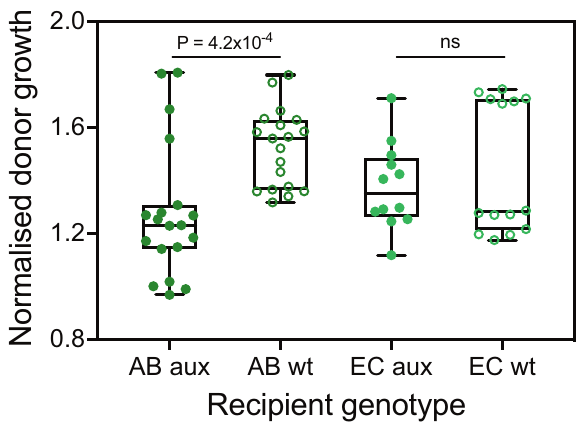
Fig. 3 Both auxotrophic and prototrophic genotypes bene fi t donors in coculture. Cocultures of donor strains with either auxotrophic (aux, fi lled circles) or prototrophic (wt, empty circles) genotypes of Acinetobacter baylyi (AB, dark green) and Escherichia coli (EC, light green) reveal signi fi cant differences in the growth of donors for A. baylyi , but not E. coli (Mann-Whitney U-Test: A. baylyi : P = 4.2 × 10 − 4 , Z = − 3.401, n = 38; E. coli : P = 0.98, Z = − 0.051, n = 26). Shown is the normalised donor growth (i.e. growth of donors in coculture minus the donor growth in monoculture divided by the growth of the cocultured auxotrophic or proto- trophic recipient after 24 h; see methods). In this experiment, a randomly chosen subset of donor strains was used that previously gained a growth advantage when cocultured with an auxotrophic recipient (Fig. 2). Boxes depict the fi rst and third quartile, the horizontal line the median, and whiskers the 1.5 interquartile range. Data points represent